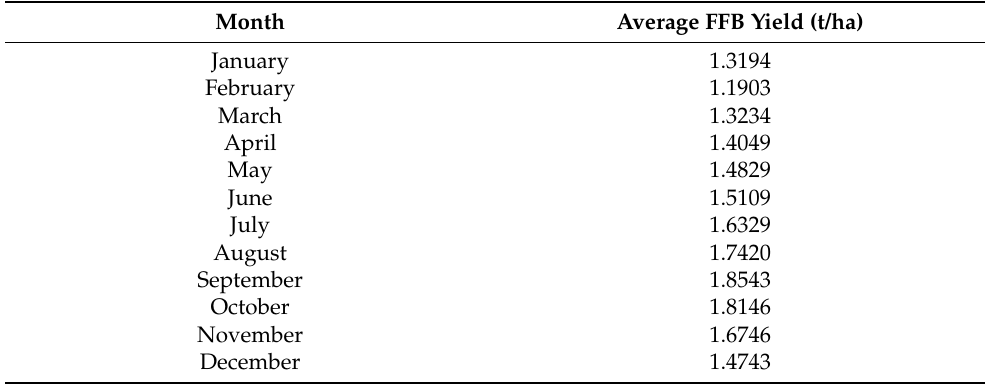
Table 3. Average FFB yield for each month from 1986 to 2020 in Malaysia. Created with data from [5–7].